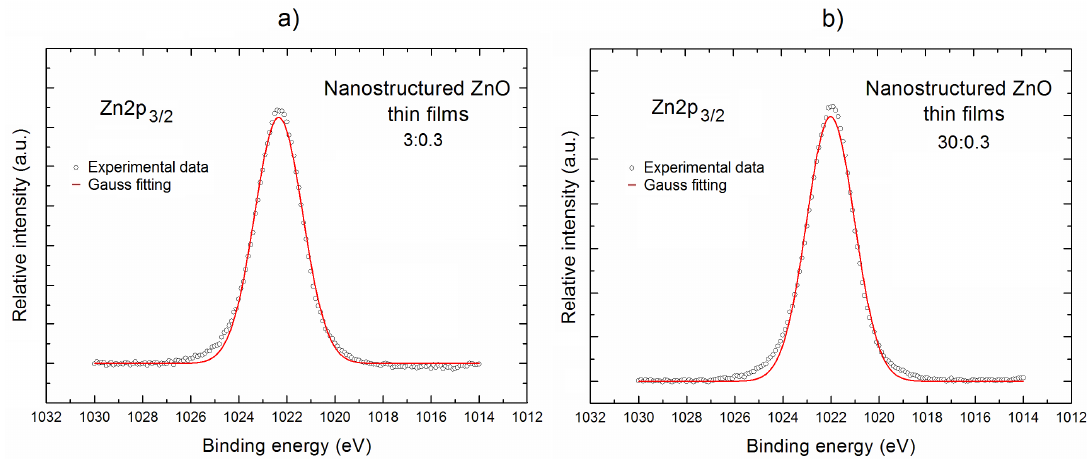
Figure 3. The XPS Zn2p 3/2 lines after deconvolution using Gauss fitting for the nanostructured ZnO thin films deposited at the Ar/O 2 gas flow of 3:0.3 ( a ) and 30:3 ( b ) (in sccm), respectively, having the most different Zn surface concentration.